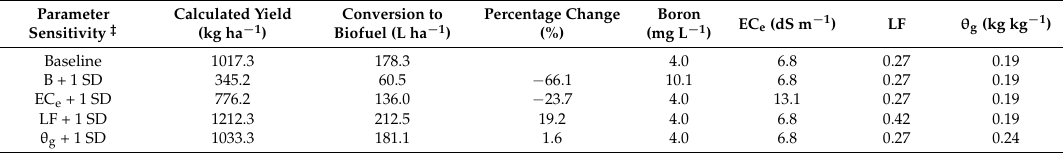
Table 4. Degree of predicted oilseed yield sensitivity to 1 standard deviation (SD) change in each edaphic property of Equation (3). †